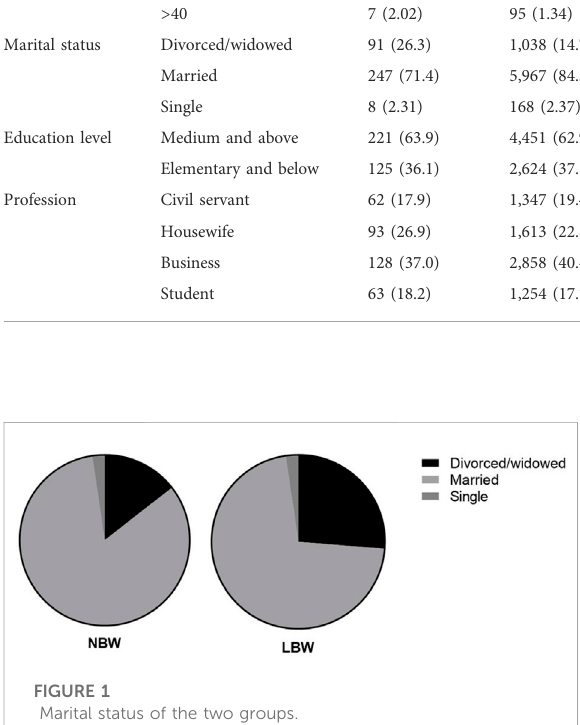
FIGURE 1 Marital status of the two groups.